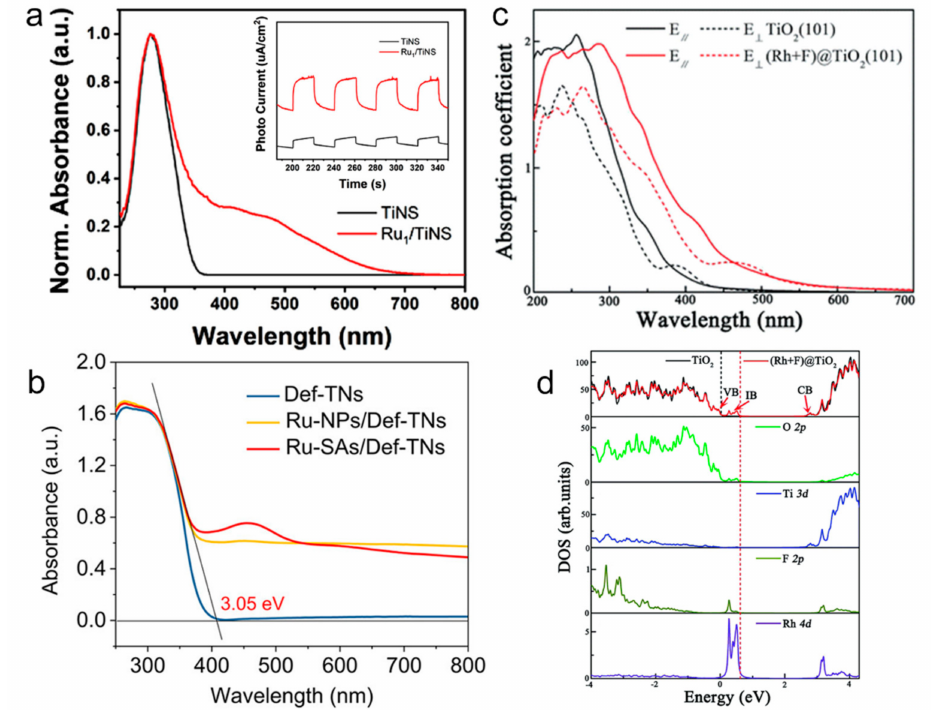
Figure 9. ( a ) UV–vis DRS of TiNS and Ru 1 /TiNS. Adapted with permission from Ref. [140] ( b ) UV- vis absorption spectra. Adopted with permission from Ref. [42] ( c ) Calculated optical absorption coefficients of the pure and (Rh + F) co-doped anatase TiO 2 (101) surfaces. (cid:107) and ⊥ represent parallel and perpendicular directions relative to the (101) surface. ( d ) Calculated total DOS of the (Rh + F) co-doped anatase TiO 2 (101) surface and partial DOS of the O, Ti, F, and Rh atoms in the co-doped system, respectively. The black line shows the total DOS of the pure anatase TiO 2 (101) surface for clarity, and the black and red vertical dashed lines represent the Fermi levels for the pure and co-doped systems, respectively. Adapted with permission from Ref.